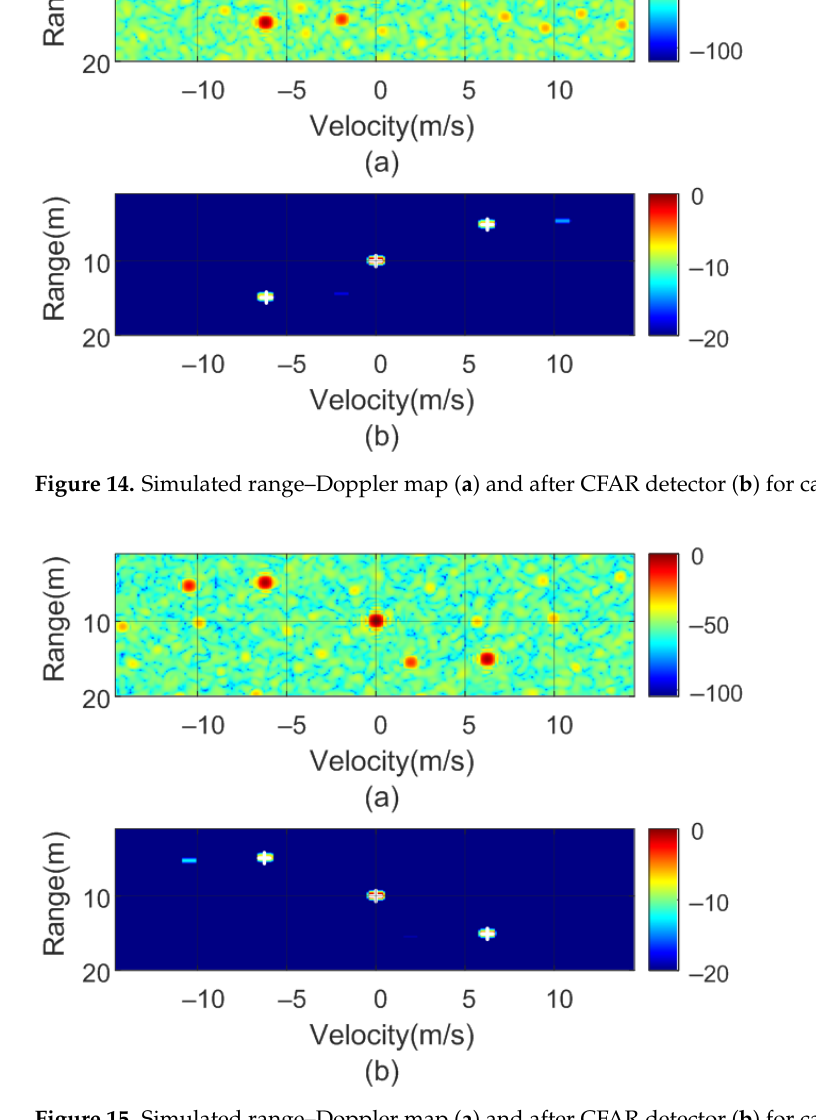
Figure 15. Simulated range–Doppler map ( a ) and after CFAR detector ( b ) for case d in Table